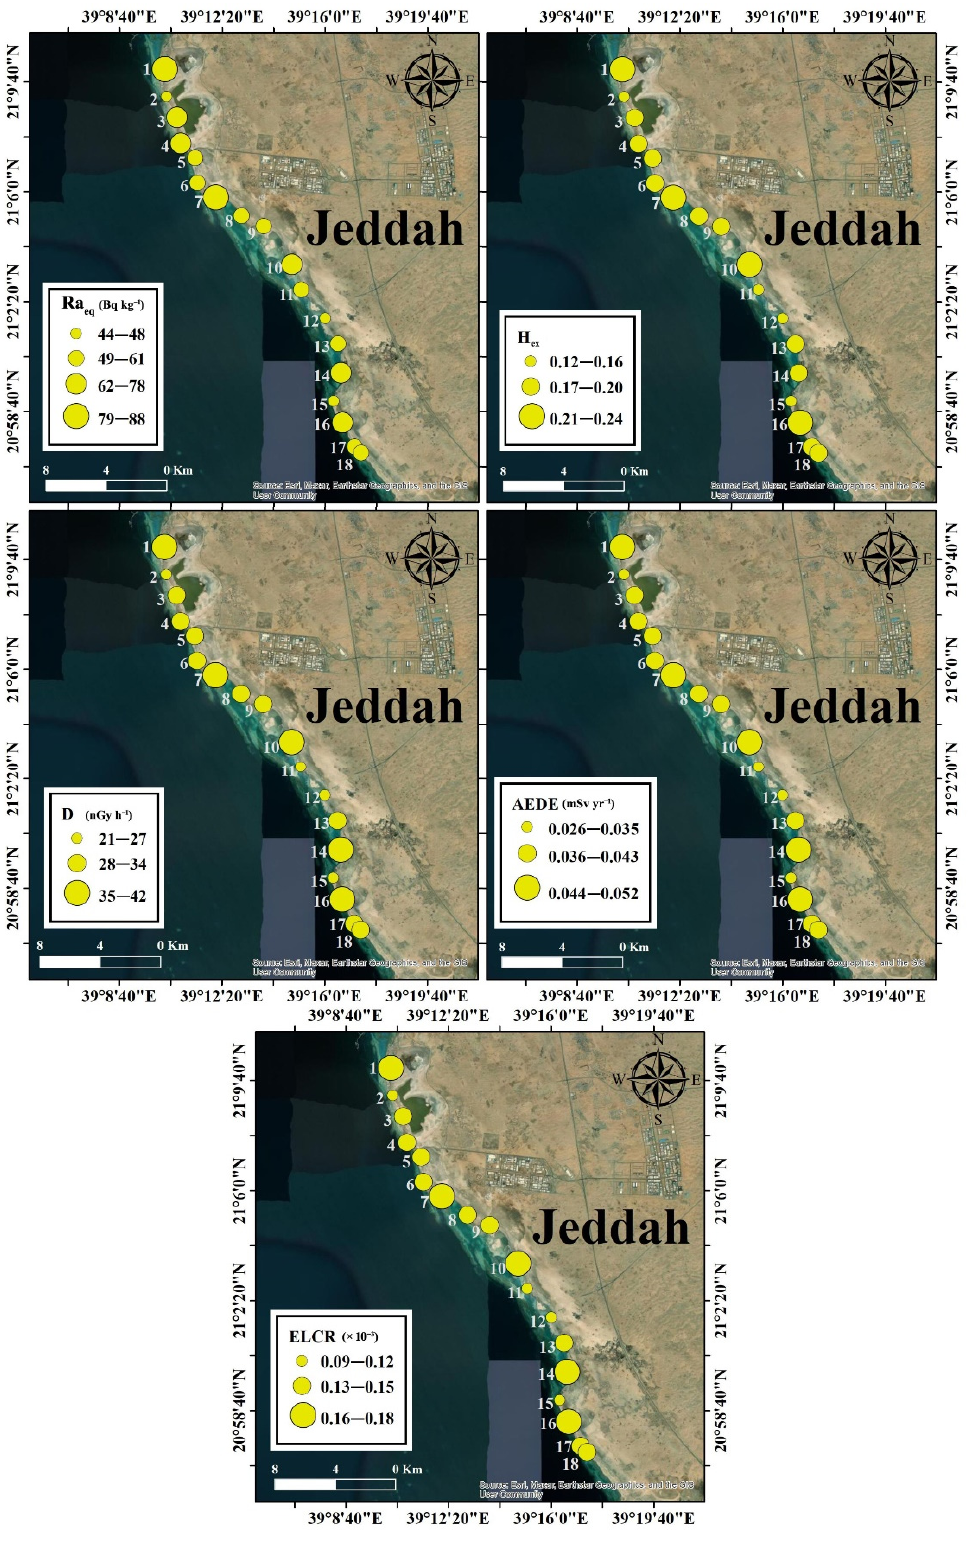
Figure 9. Distribution pattern maps of radiological risk parameters.